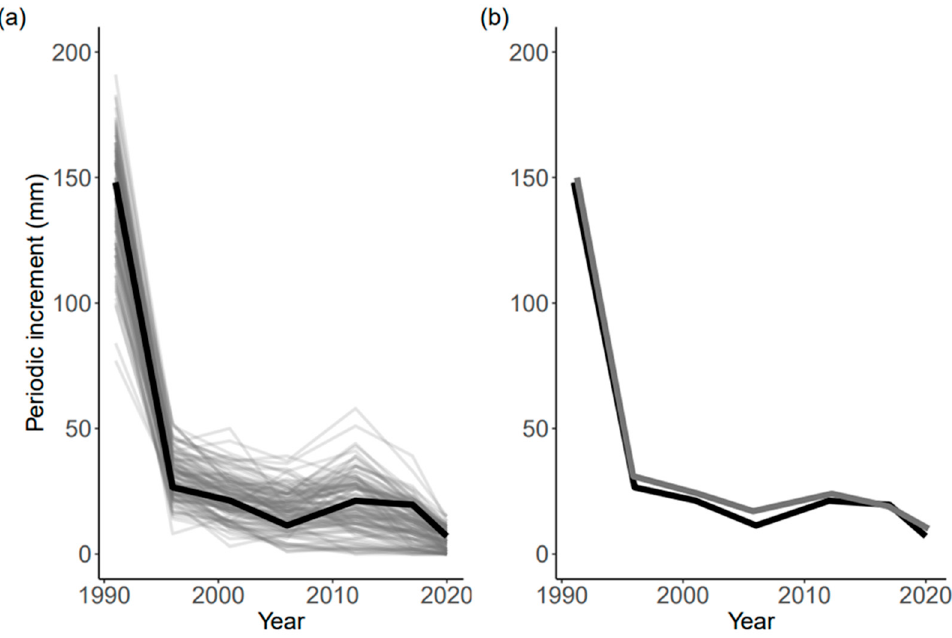
Figure A1. ( a ) Comparison of the periodic growth trajectories during the pairing process. The cored tree from the buffer zone is marked black, while the gray lines represent the corresponding trees from within the plot. ( b ) Best match between the cored tree (black) and the respective tree from the plot (gray) based on the lowest sum of squares. The high periodic increment at the beginning reflects the growth of the first 22 years of life until the first survey.